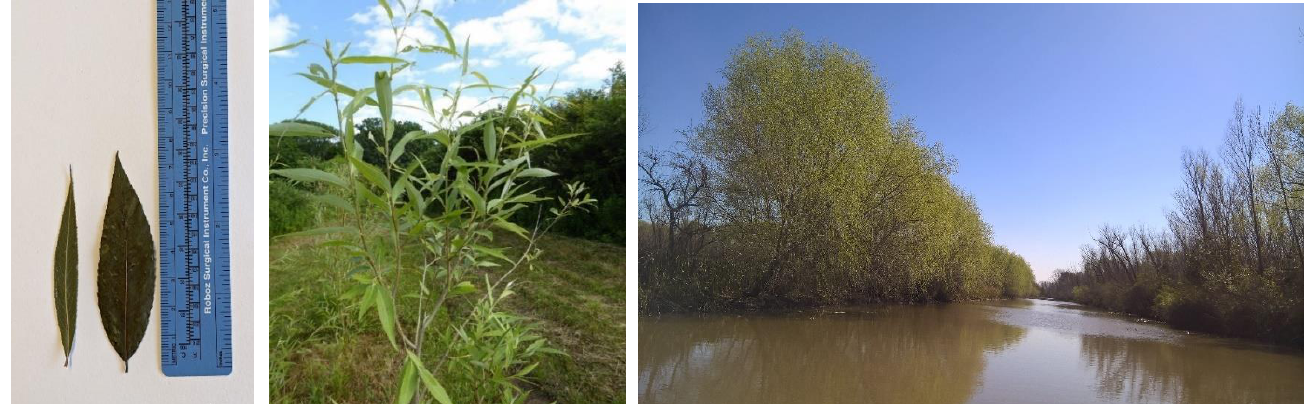
Figure 1. ( Left ) Narrow-lanceolate leaves of S. babylonica ’Babylon’ ( left ) and lanceolate leaves of S. babylonica var. sacramenta ( right ). ( Center ) The green-gray bark of S. babylonica var. sacramenta retains its color even on the side exposed to the sun . Right: S. babylonica var. sacramenta in the Paraná Delta region, Argentina (photo by T. Cerrillo).